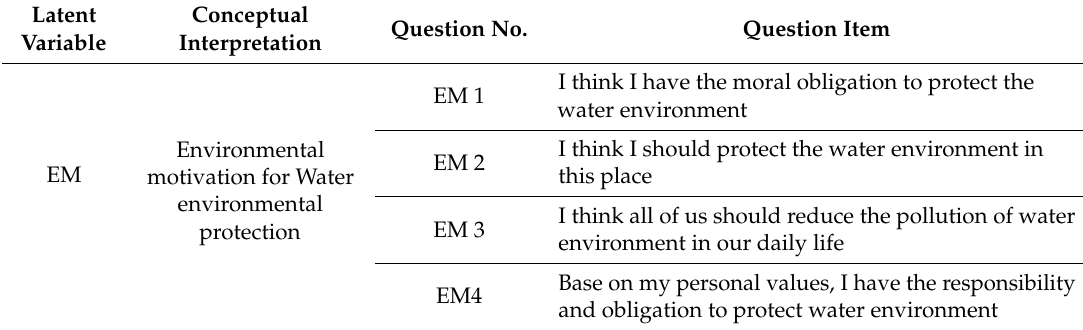
Table 6. Measurement table for